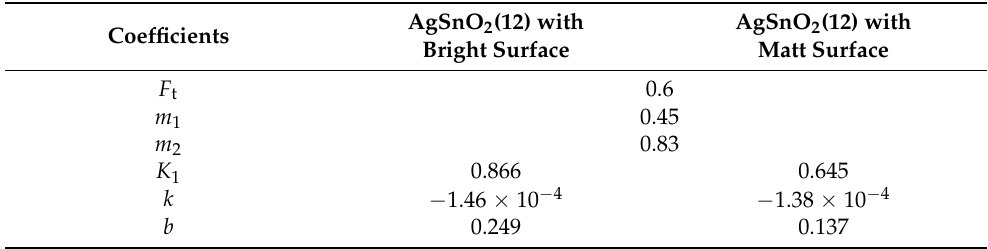
Table 3. Fitting coefficients of electrode materials with bright and matt